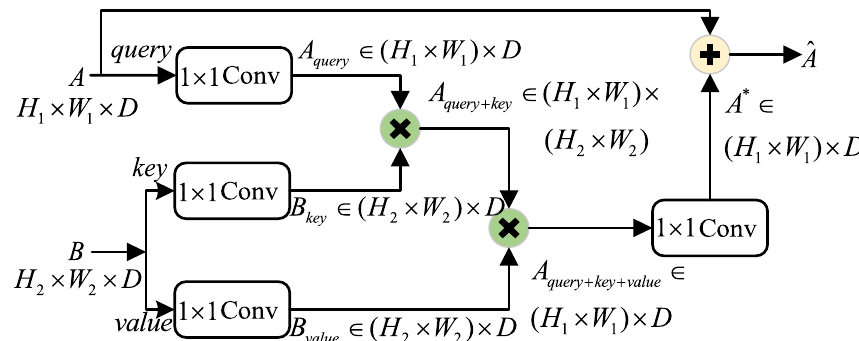
Fig. 4 Non-local network structure